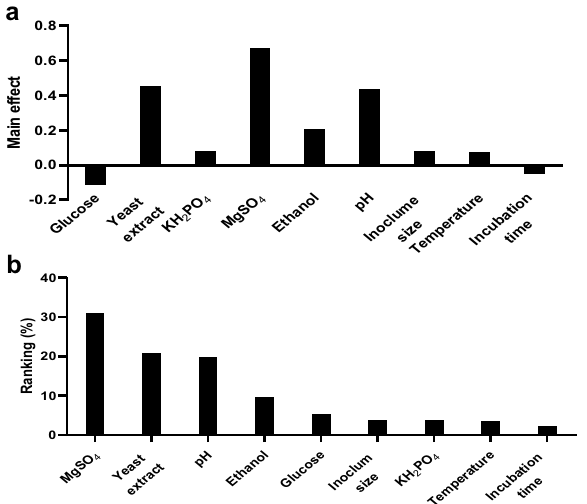
Figure 4. PBD results representing ( a ) The direct impact of the studied variables (in range of -1 to 1 for each variable as defined in Table 2), upon BC production, where ( b ) Pareto chart representing the relative ranking (%) of the magnitude of the culture conditions upon total BC production